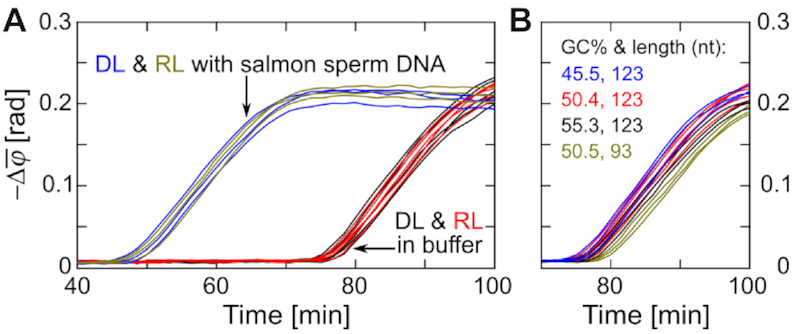
Optomagnetic performance of RL without Cas12a. (A) Real-time changes of \documentclass[12pt]{minimal}
\usepackage{amsmath}
\usepackage{wasysym}
\usepackage{amsfonts}
\usepackage{amssymb}
\usepackage{amsbsy}
\usepackage{upgreek}
\usepackage{mathrsfs}
\setlength{\oddsidemargin}{-69pt}
\begin{document}
}{}$\bar{\varphi }$\end{document} (1–10 Hz) for the detection of background amplifications in clean buffer (n = 5) and in buffer containing nonspecific DNA (n = 3) using DL and RL. (B) Real-time changes of \documentclass[12pt]{minimal}
\usepackage{amsmath}
\usepackage{wasysym}
\usepackage{amsfonts}
\usepackage{amssymb}
\usepackage{amsbsy}
\usepackage{upgreek}
\usepackage{mathrsfs}
\setlength{\oddsidemargin}{-69pt}
\begin{document}
}{}$\bar{\varphi }$\end{document} (1–10 Hz) for different RL designs. GC content and length of different RL designs are indicated in panel. Independent replicates are plotted in the same color.